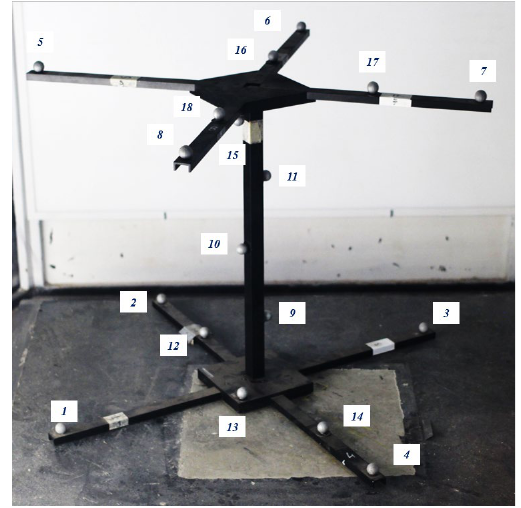
Figure 8. Picture of the calibration